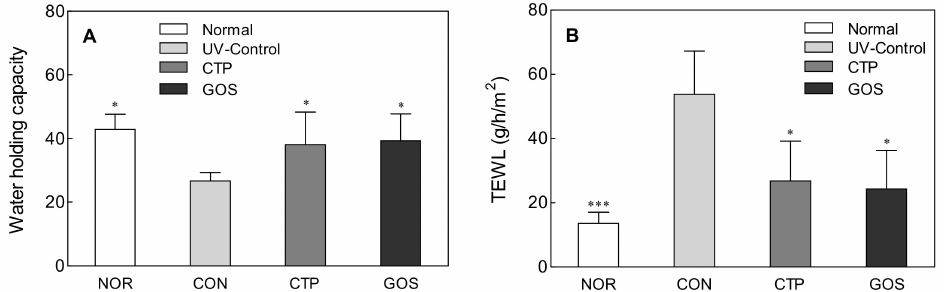
Figure 1. E ff ect of galacto-oligosaccharide (GOS) intake on the water holding capacity ( A ) and transepidermal water loss (TEWL) ( B ) in ultraviolet (UV) B-irradiated hairless mice. Data are expressed as mean ± standard deviation, and di ff erent symbols indicate significant di ff erences at * p < 0.05 and *** p < 0.001 vs. CON group. Normal (NOR; unirradiated mice); ultraviolet (UV) B control (CON; irradiated and untreated mice); collagen tripeptide (CTP) intake at 200 mg / kg (CTP; irradiated and CTP-treated mice); GOS intake at 200 mg / kg (GOS; irradiated and GOS-treated mice).